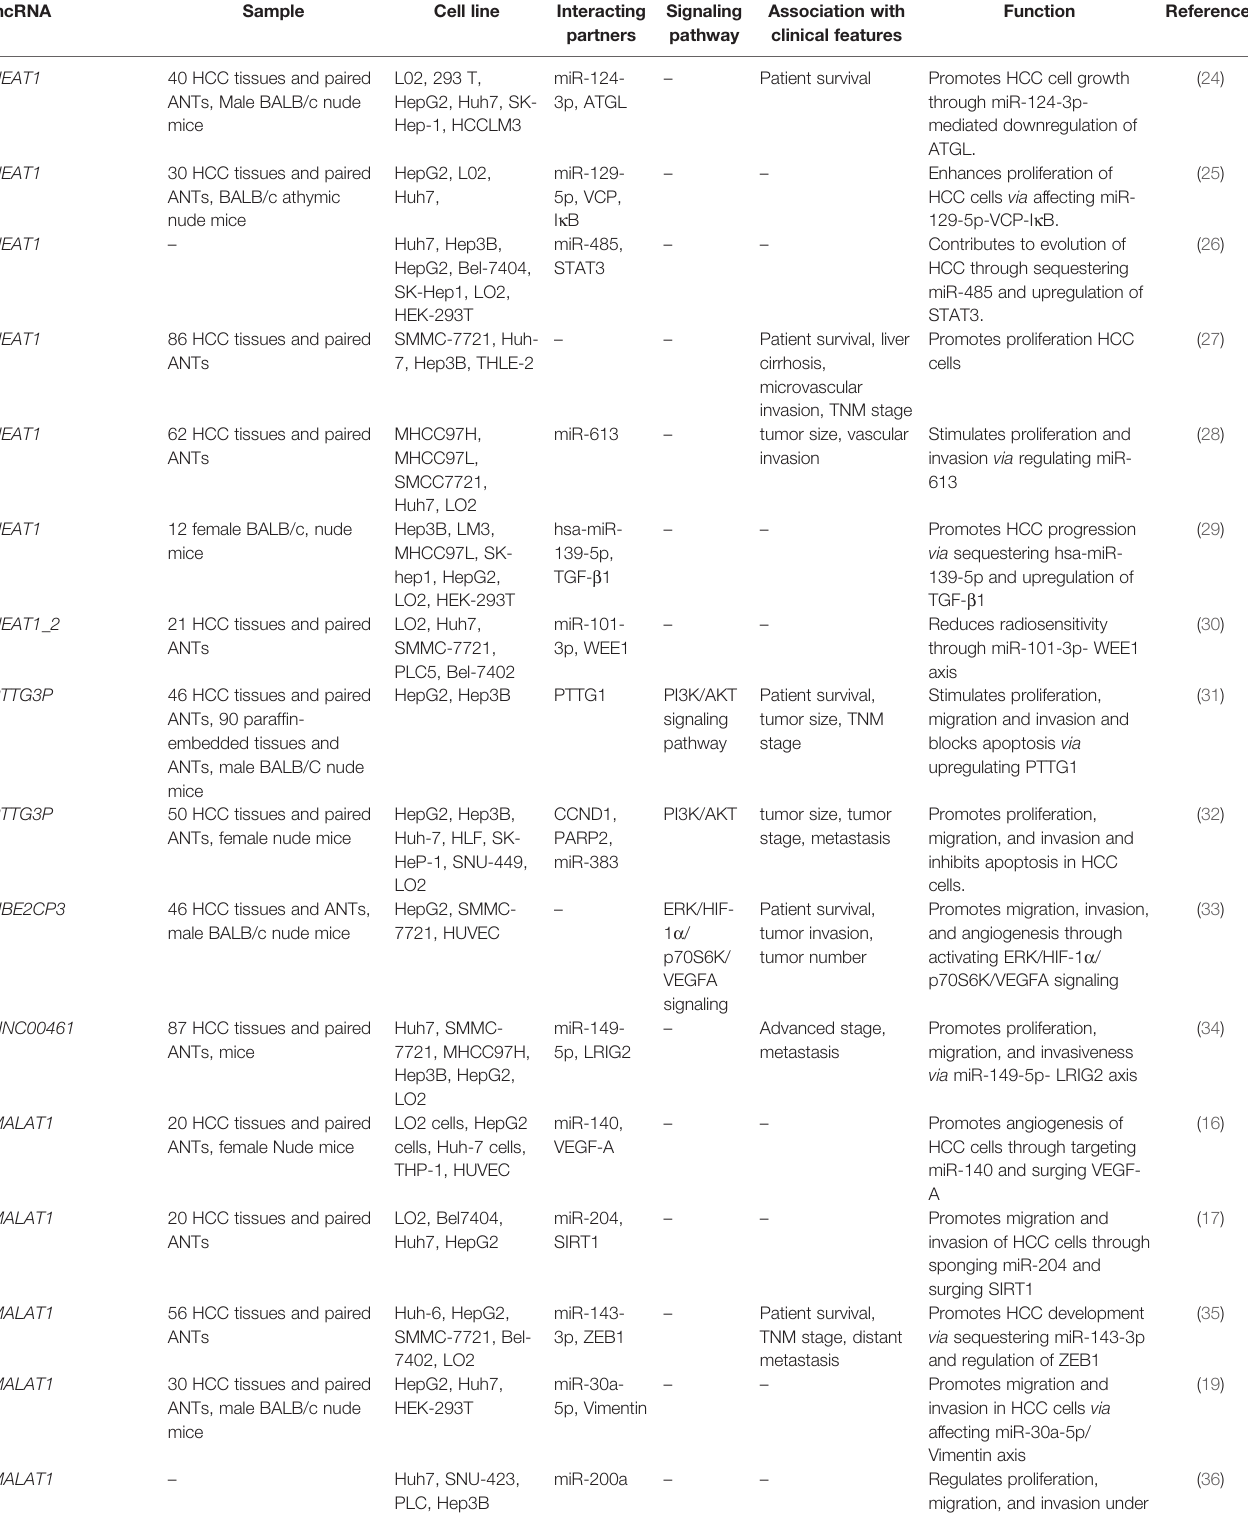
TABLE 1 | Function of over-activated lncRNAs in HCC (ANT, adjacent non-cancerous tissue; HBS Ag, hepatitis B surface antigen).